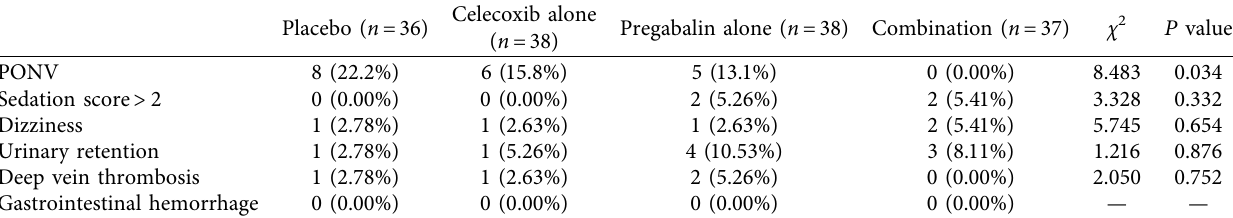
Table 4: Incidence of postoperative complications.